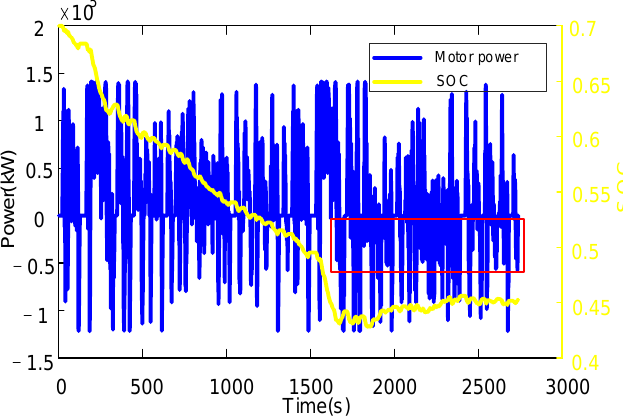
Figure 11. SOC trajectory at reference SOC of 0.45 and EM power.